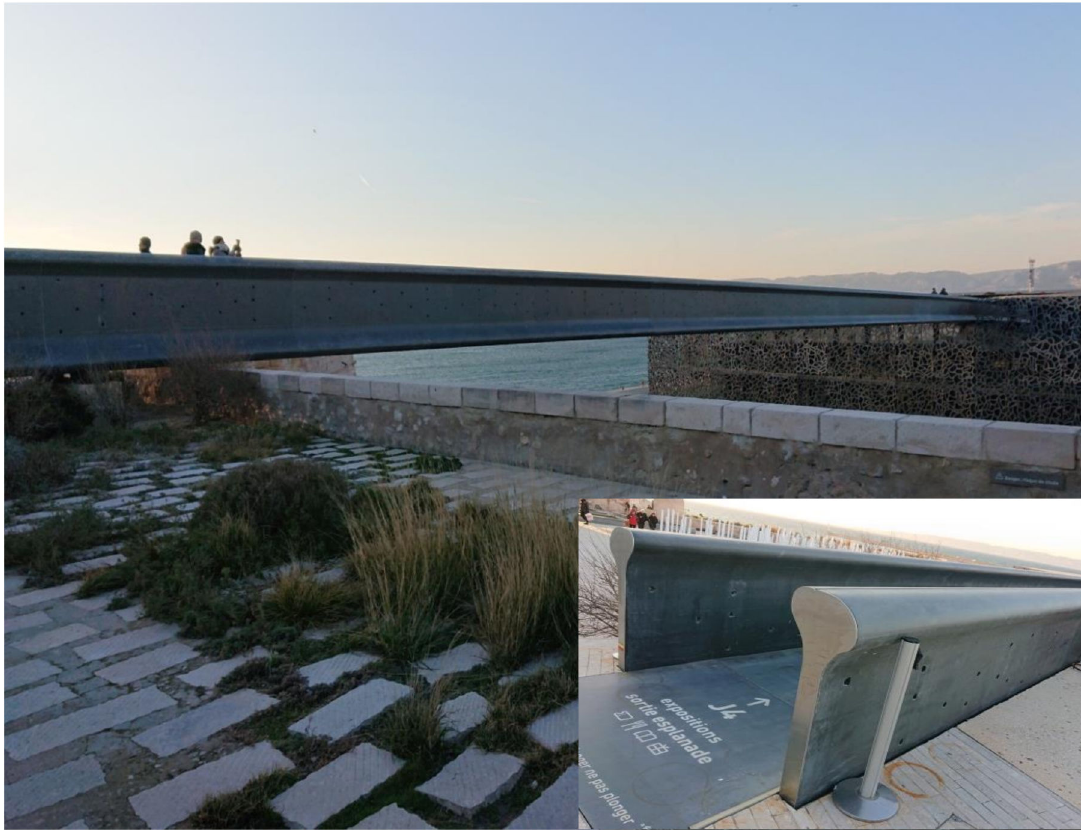
Figure 1. Application of ultrahigh performance concrete (UHPC) in MuCEM pedestrian bridge (Marseille,